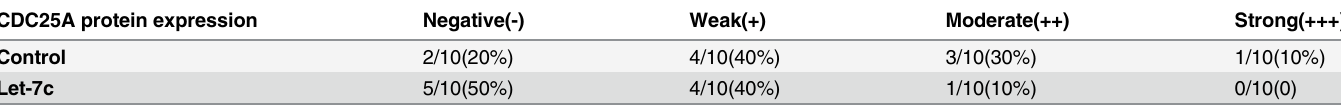
Table 1. Effect of let-7c on CDC25A protein expression in HCC xenograft tumors. CDC25A protein